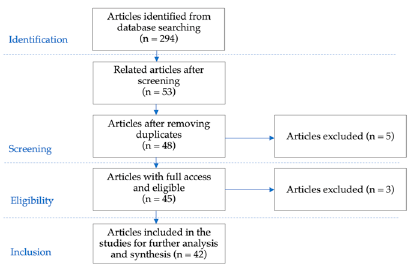
Figure 1. Process of article